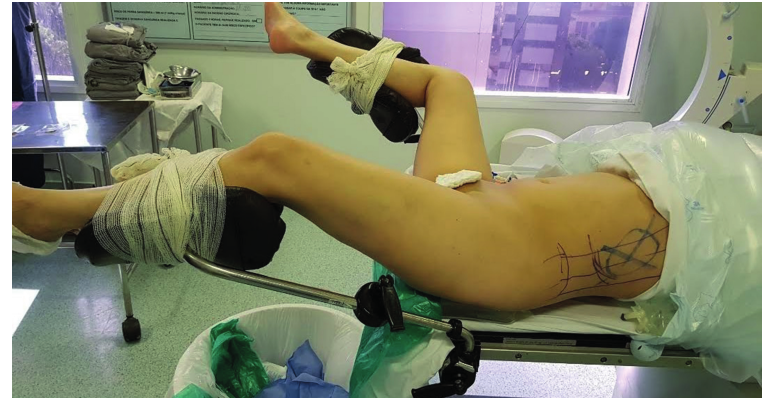
Figure 4 - Galdakao